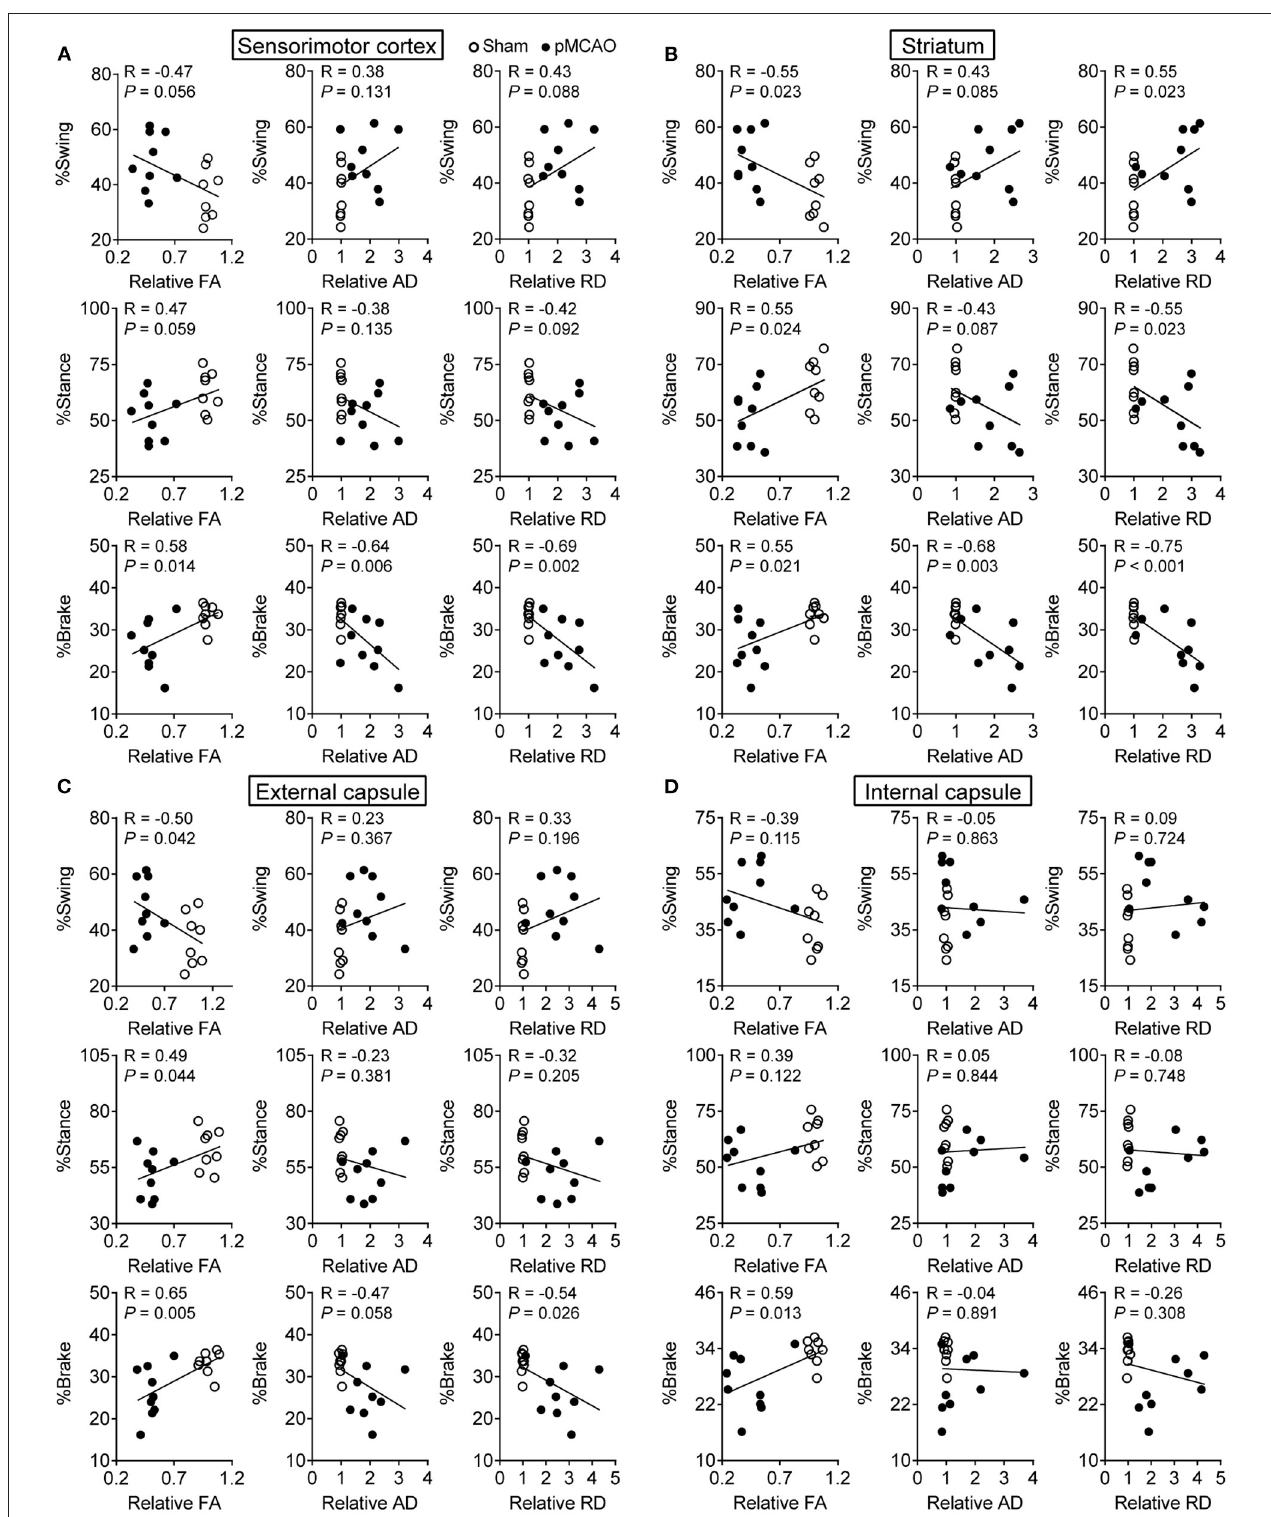
FIGURE 6 | pMCAO induced motor dysfunctions were correlated to gray and white matter damages in rats. Correlational analysis between the gait data and DTI parameters obtained from the (A) sensorimotor cortex, (B) striatum, (C) external capsule, and (D) internal capsule.